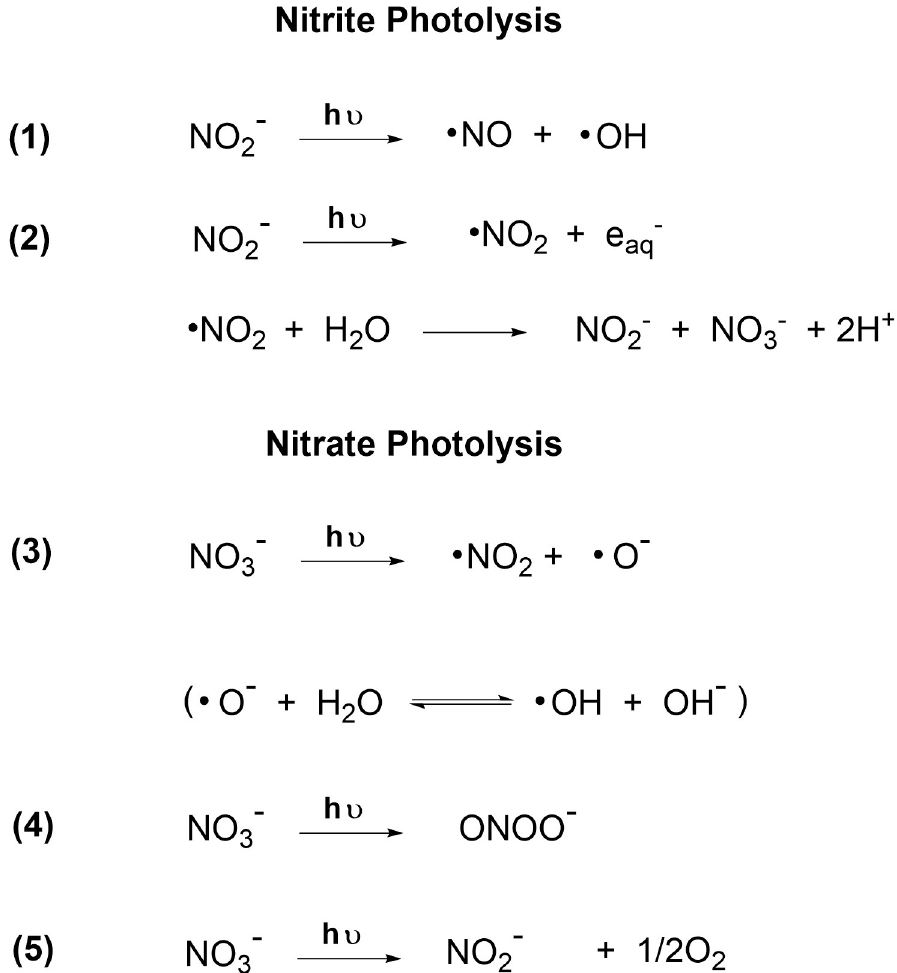
Fig 5. Nitrite and nitrate photolysis